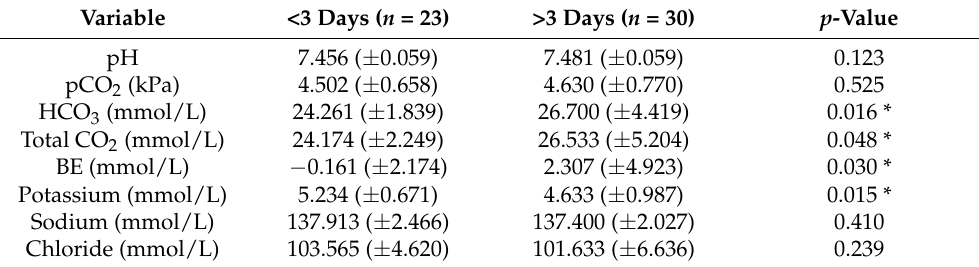
Figure 2. Scatterplots: ( a ) correlation of duration of vomiting and pH in the pylorostenosis group; ( b ) correlation of duration of vomiting and pH in the control group. Table 3. Influence of the duration of vomiting on acid-base status in the pylorostenosis group.